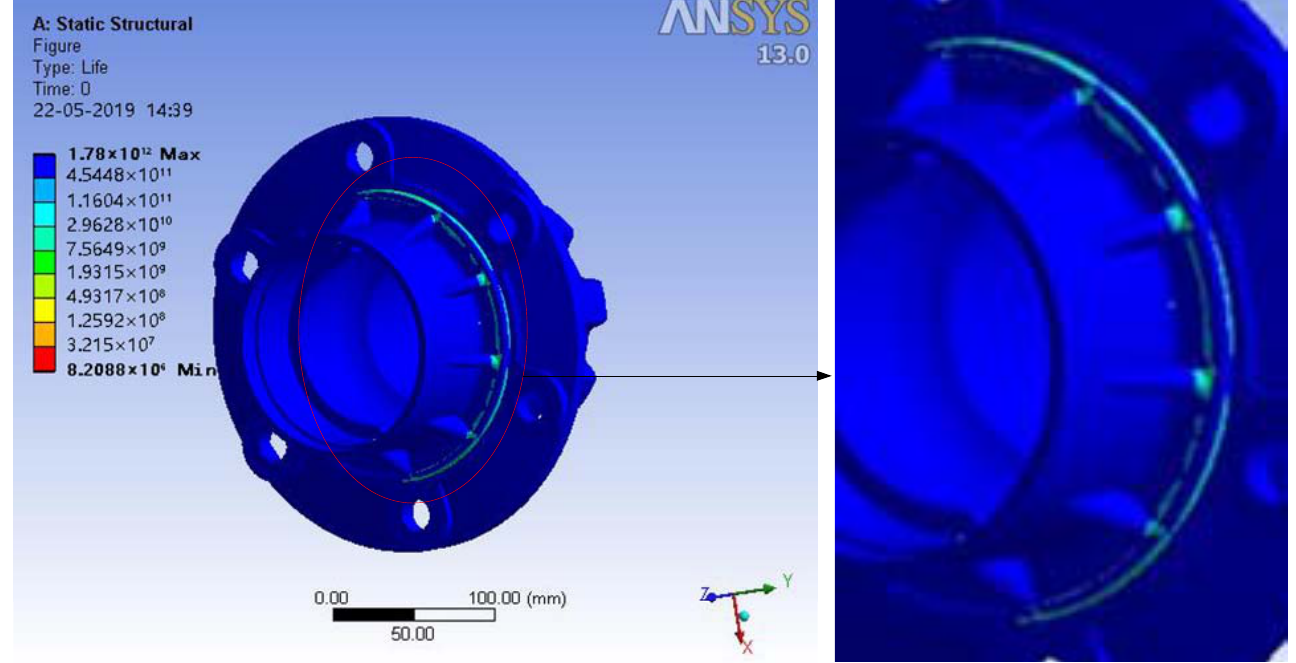
Figure 12. Number of life cycles of the wheel hub after the lightweight design (including a partial enlarged view).